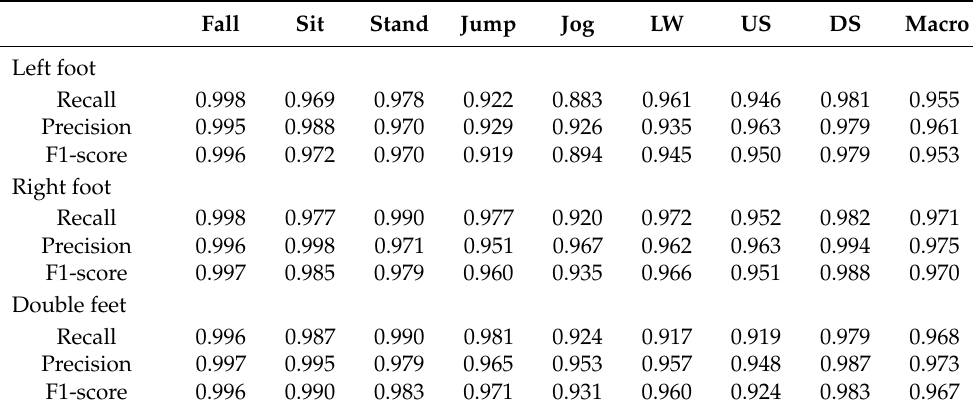
Table 7. Results on the detections of fall and physical activities based on foot pressures, center of pressure, inertial data and inertial parameters obtained from a single foot or both feet. Fall Sit Stand Jump Jog LW US DS Macro